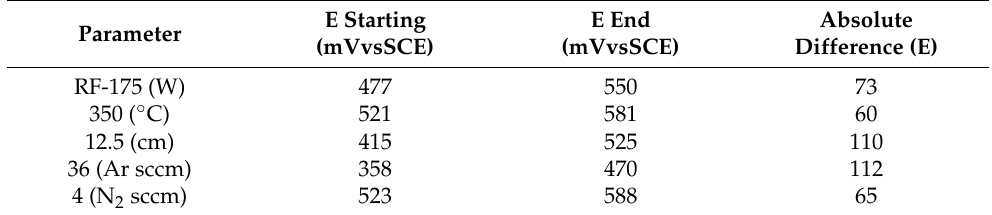
Table 2. Fitting results of OCP curves with best behavior were immersed in 3.5% NaCl solution for 1600